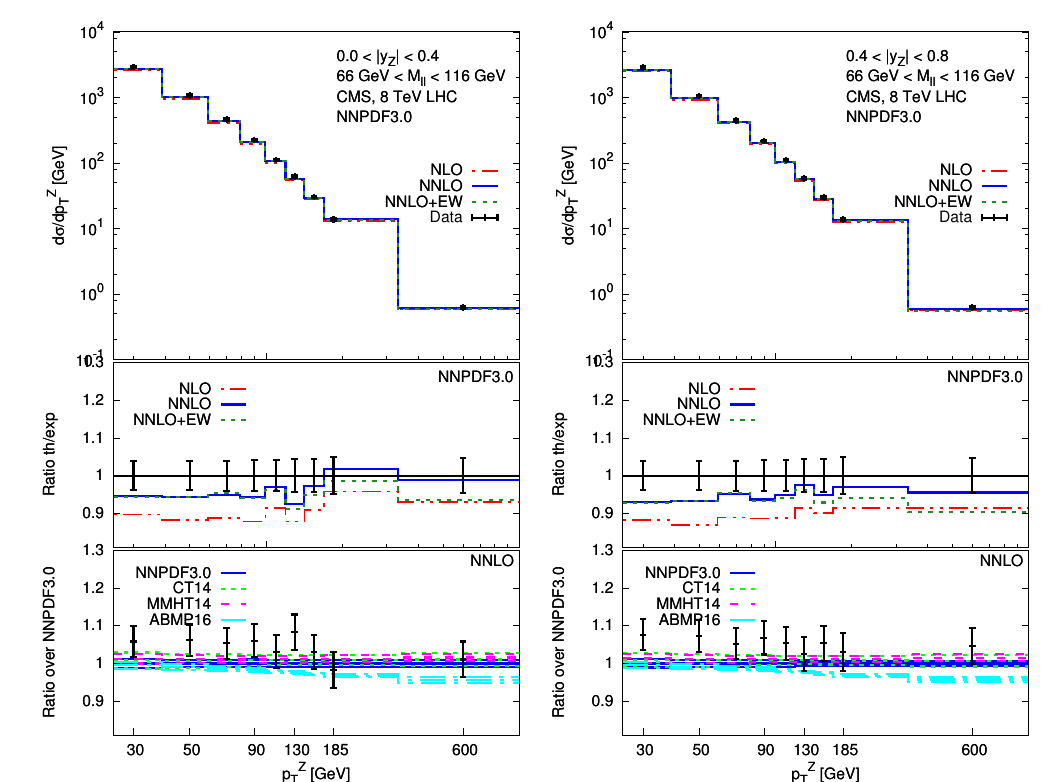
Figure 6 . Same as (cid:12)gure 1 for the CMS on-peak 8 TeV data divided into rapidity bins [16]. Only the total uncertainty of data points is displayed, given that separate statistical and uncorrelated uncertainties are not